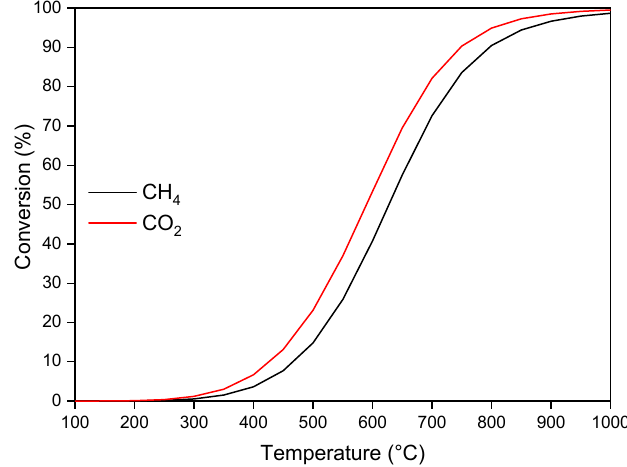
Figure 7. Reactant conversion and H 2 /CO molar ratio at the thermodynamic equilibrium of the DRM reaction assuming no carbon formation.